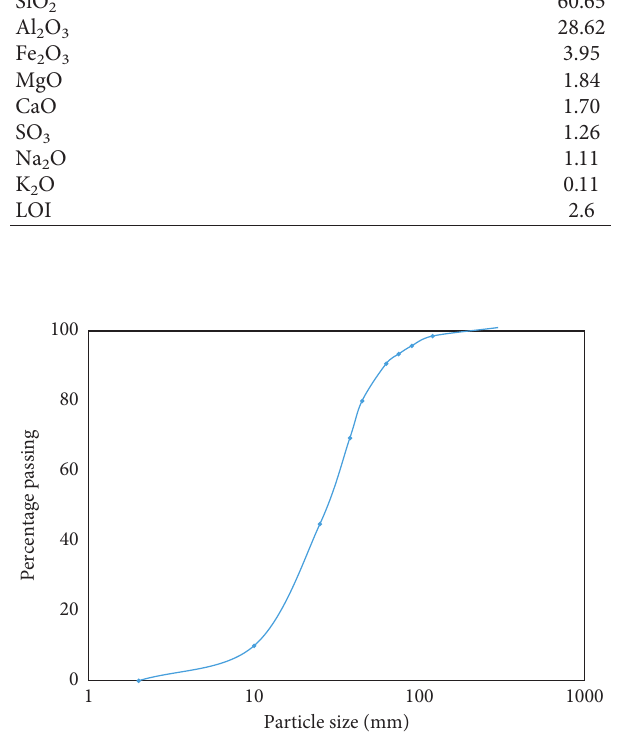
Figure 1: Particle size distribution of fly